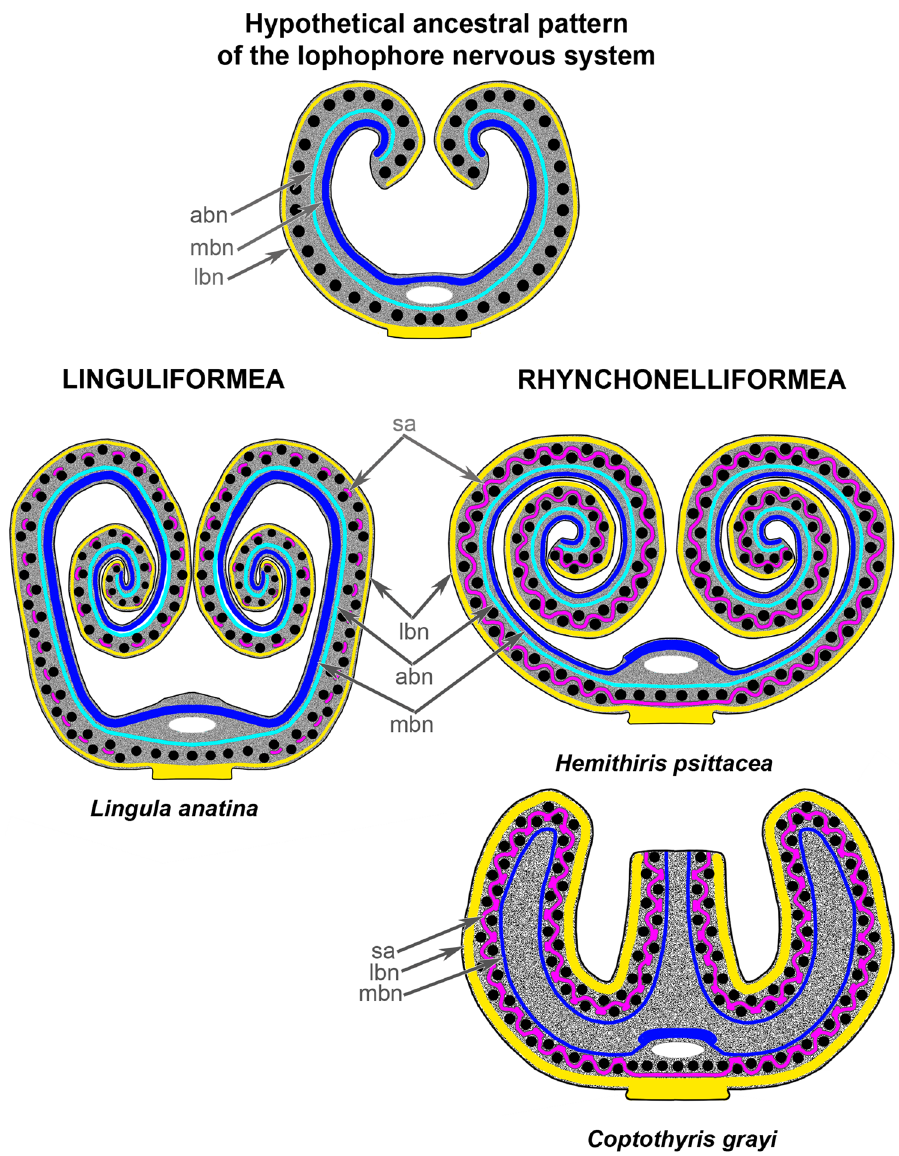
Figure 12. Scheme of the lophophore nervous system in various brachiopods. The black circles indicate tentacles. Abbreviations: abn—accessory brachial nerve; lbn—lower brachial nerve; mbn—main brachial nerve; sa—second accessory brachial